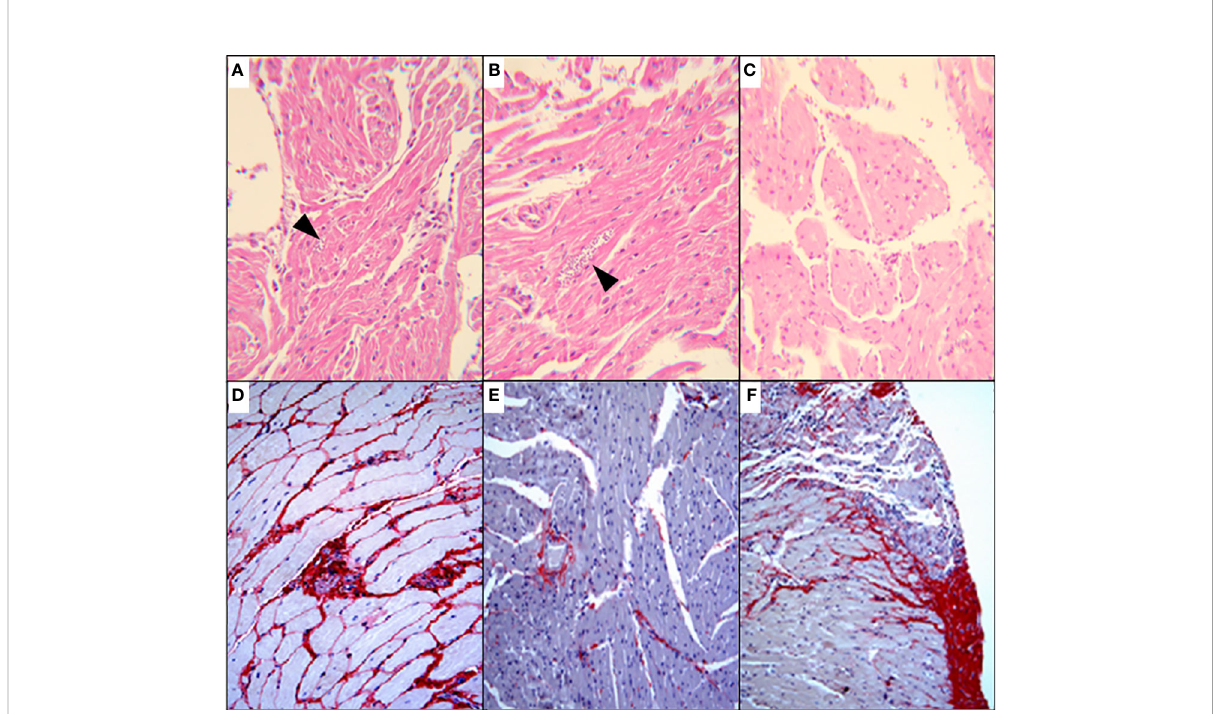
FIGURE 13 Histopathological analysis (H&E) of murine myocardium T. cruzi (Y strain)-infected mice, treated for 60 consecutive days, p.o. with vehicle (A) ; 10 mg/kg/d BZ-treated and (B) treated with the of 10 mg/kg/d DETC combined to 10 mg/kg/d BZ (C) . Amastigote nests were observed in A and B (arrowheads). Skeletal muscle of mice infected with Colombiana strain, for 100 d and treated for 30 consecutive days orally with 20 mg/kg/d BZ (D) , 20 mg/kg/d DSF (E) or combination of 10 mg/kg/d each (F) . Picro Sirius red staining was employed to demonstrate fi brosis. The